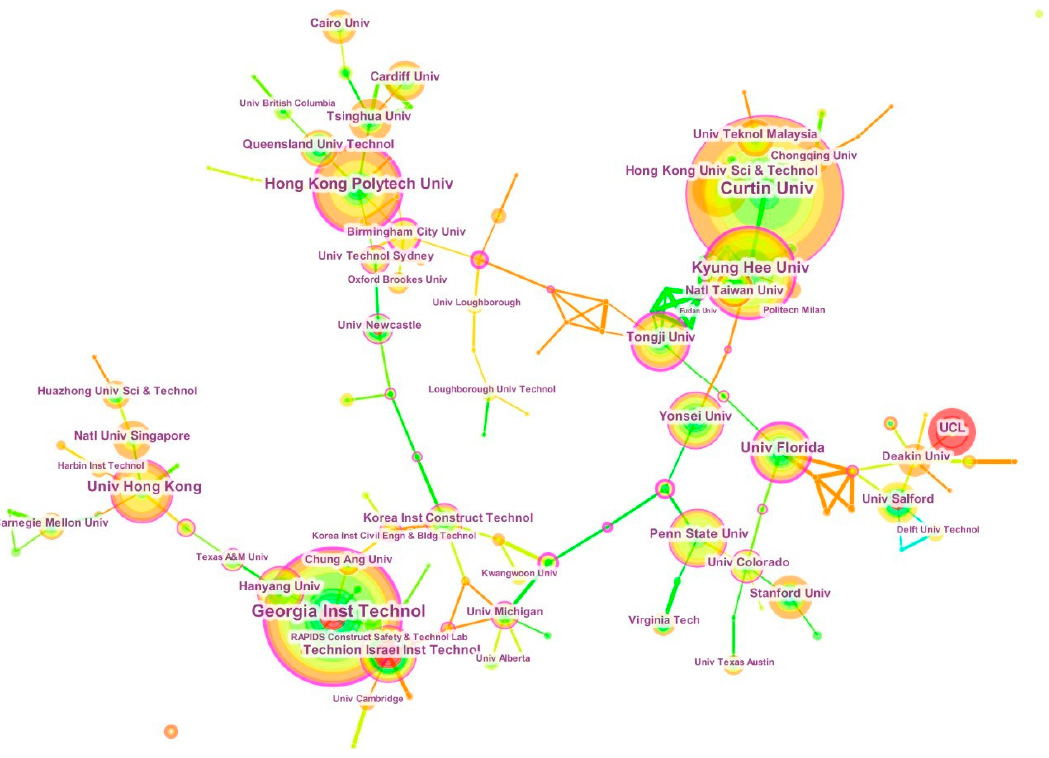
Figure 6. Network of research institutes.